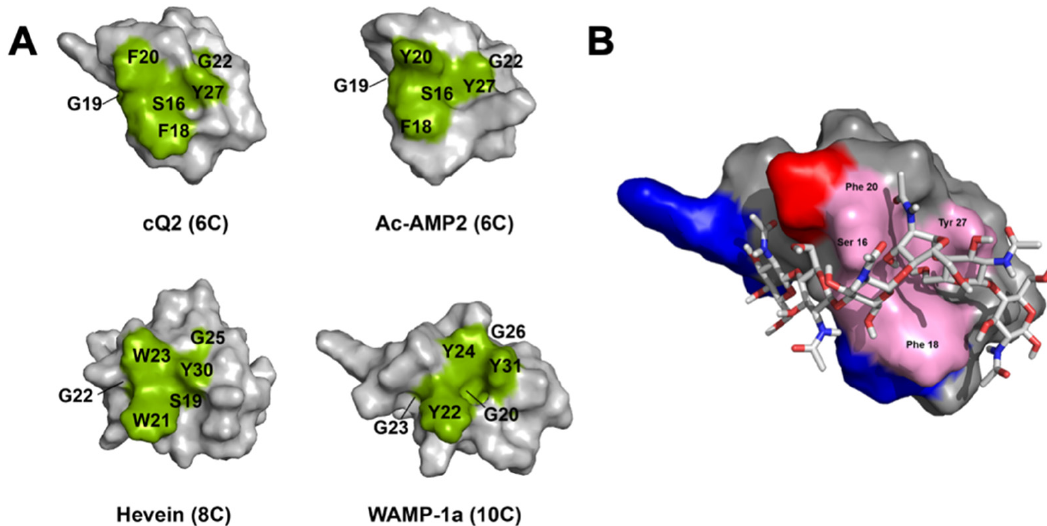
Figure 4. Chenotides belong to the family of chitin-binding hevein-like peptides. ( A ) Surface topology comparison of chenotide cQ2 (PDB: 5ZV6), Ac-AMP2 (PDB: 1MMC), hevein (PDB: 1HEV), and WAMP-1a (PDB: 2LB7). The residues highlighted in green represent the chitin-binding domain. ( B ) Surface representation of the peptide–ligand interaction between chenotide cQ2 and chitin ( N -Acetylglucosamine hexamer). N -Acetylglucosamine is shown in ball and stick. Residues highlighted in blue and red are basic (Arg, His, Lys) and acidic (Asp, Glu), respectively.